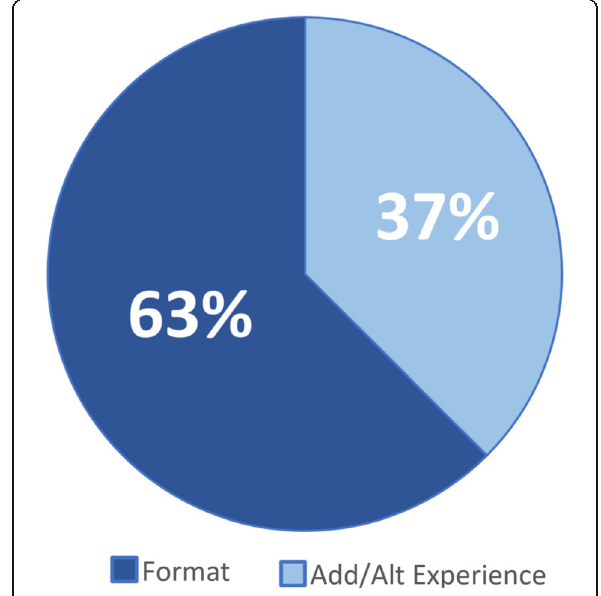
Fig. 15 Tertiary breakdown of reasoning inherent to